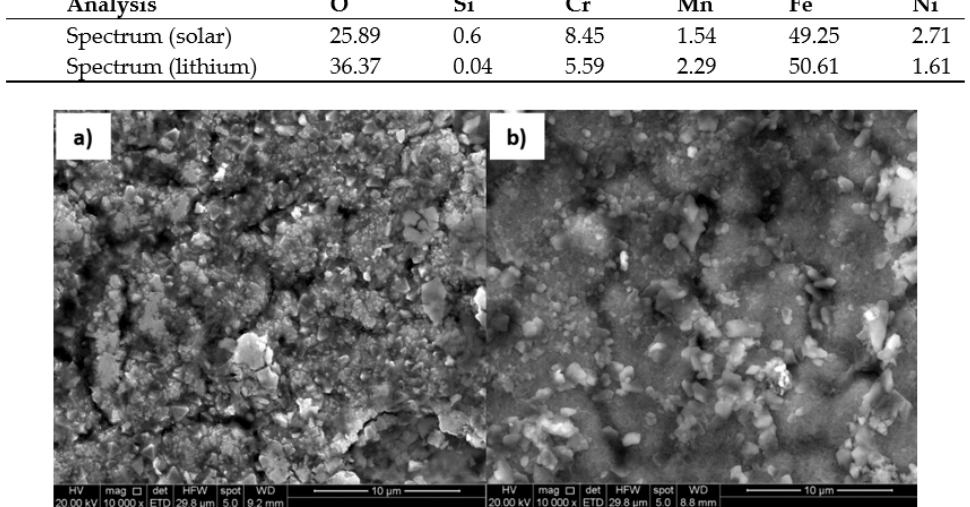
Figure 18. Surface of AISI 304 stainless steel in ( a ) Solar Salt ( b ) LiNaKNO 3 , at 550 °C after 100 h.